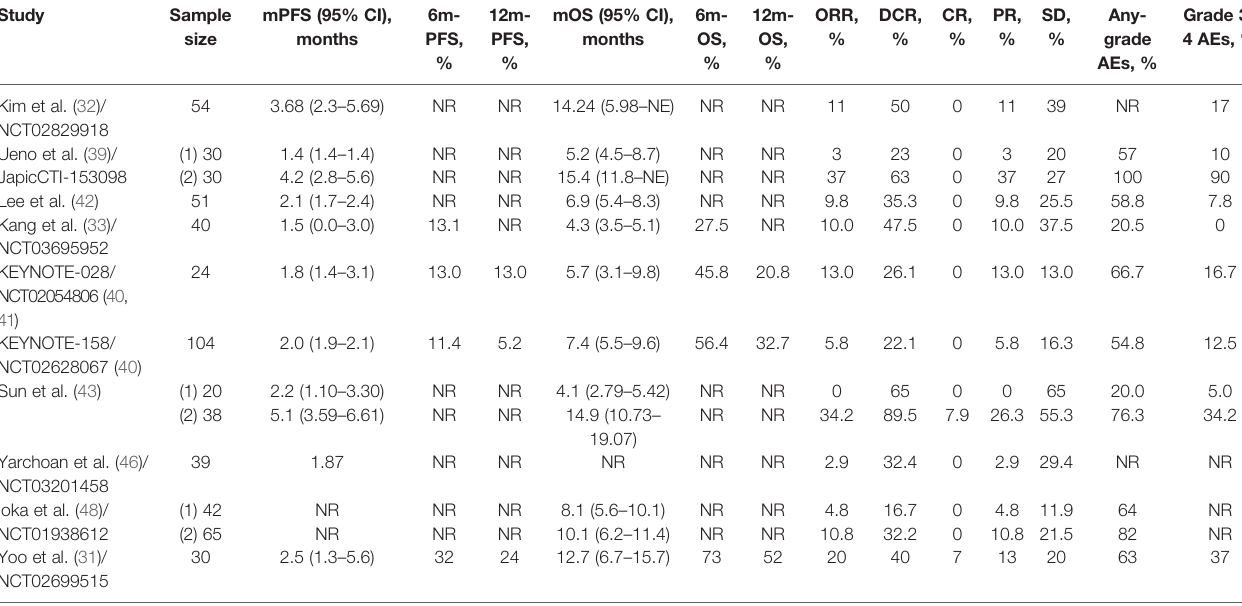
TABLE 2 | Main outcomes extracted from included studies with anti-PD1/PDL1 in